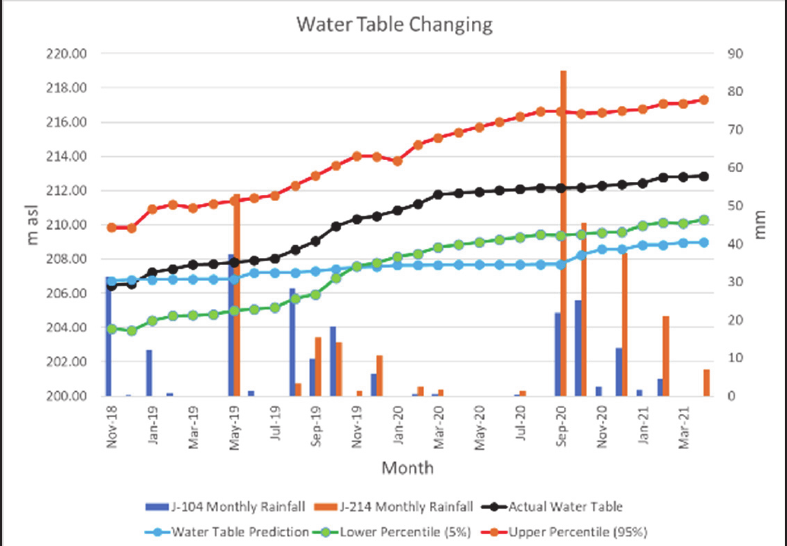
Figure 21. Monthly rainfall and water table time series as the result of transient groundwater modeling using potential recharge from monthly